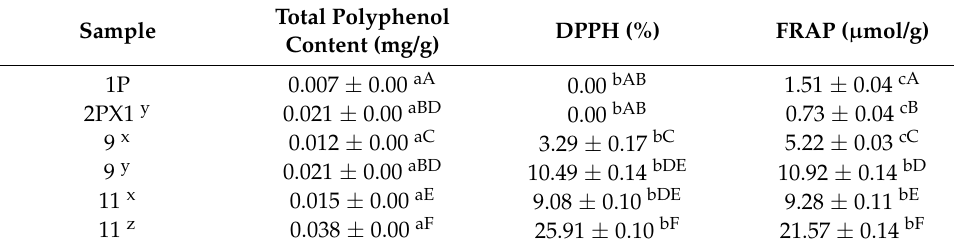
Table 9. Determination of total polyphenols and antioxidant activity by DPPH and